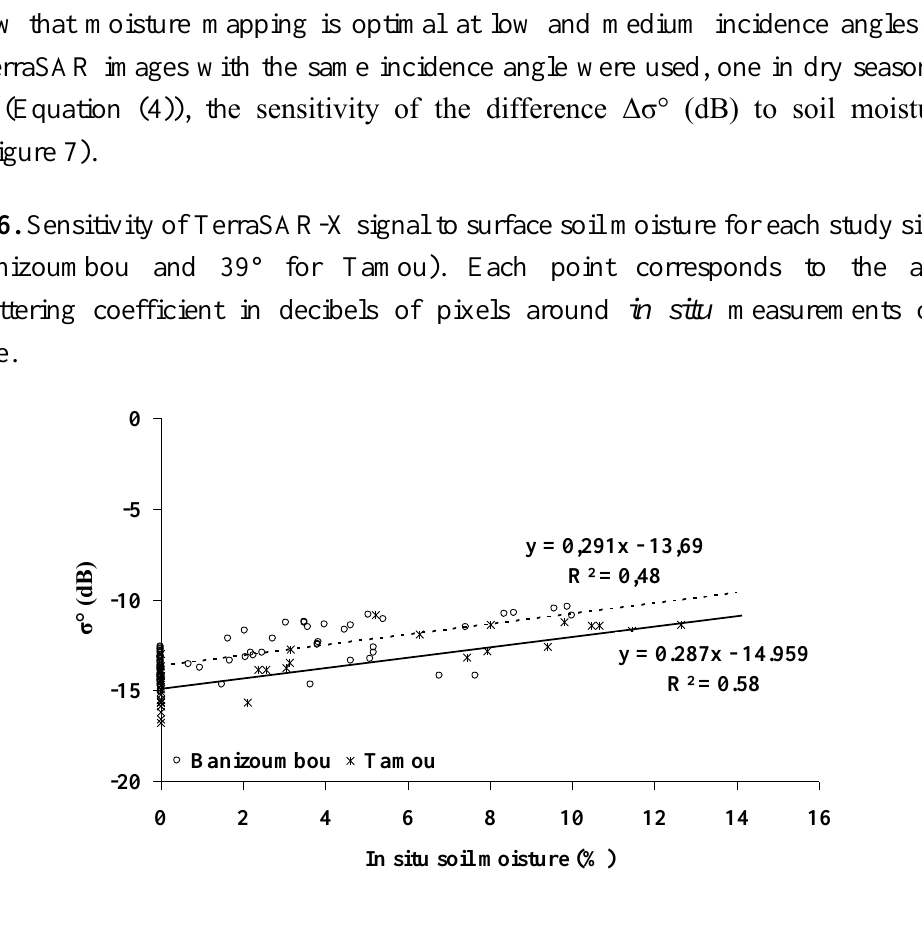
Figure 7. The difference between TerraSAR images acquired in rainy season and one reference image acquired in dry season according to soil